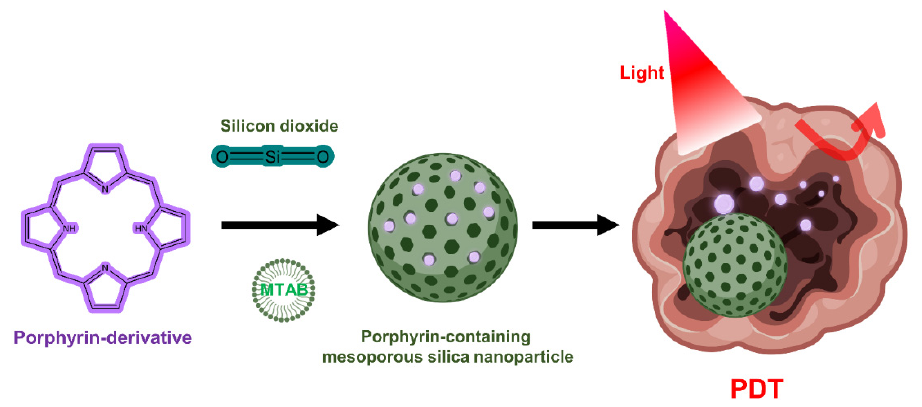
Figure 4. Porphyrin-containing mesoporous silica nanoparticles for